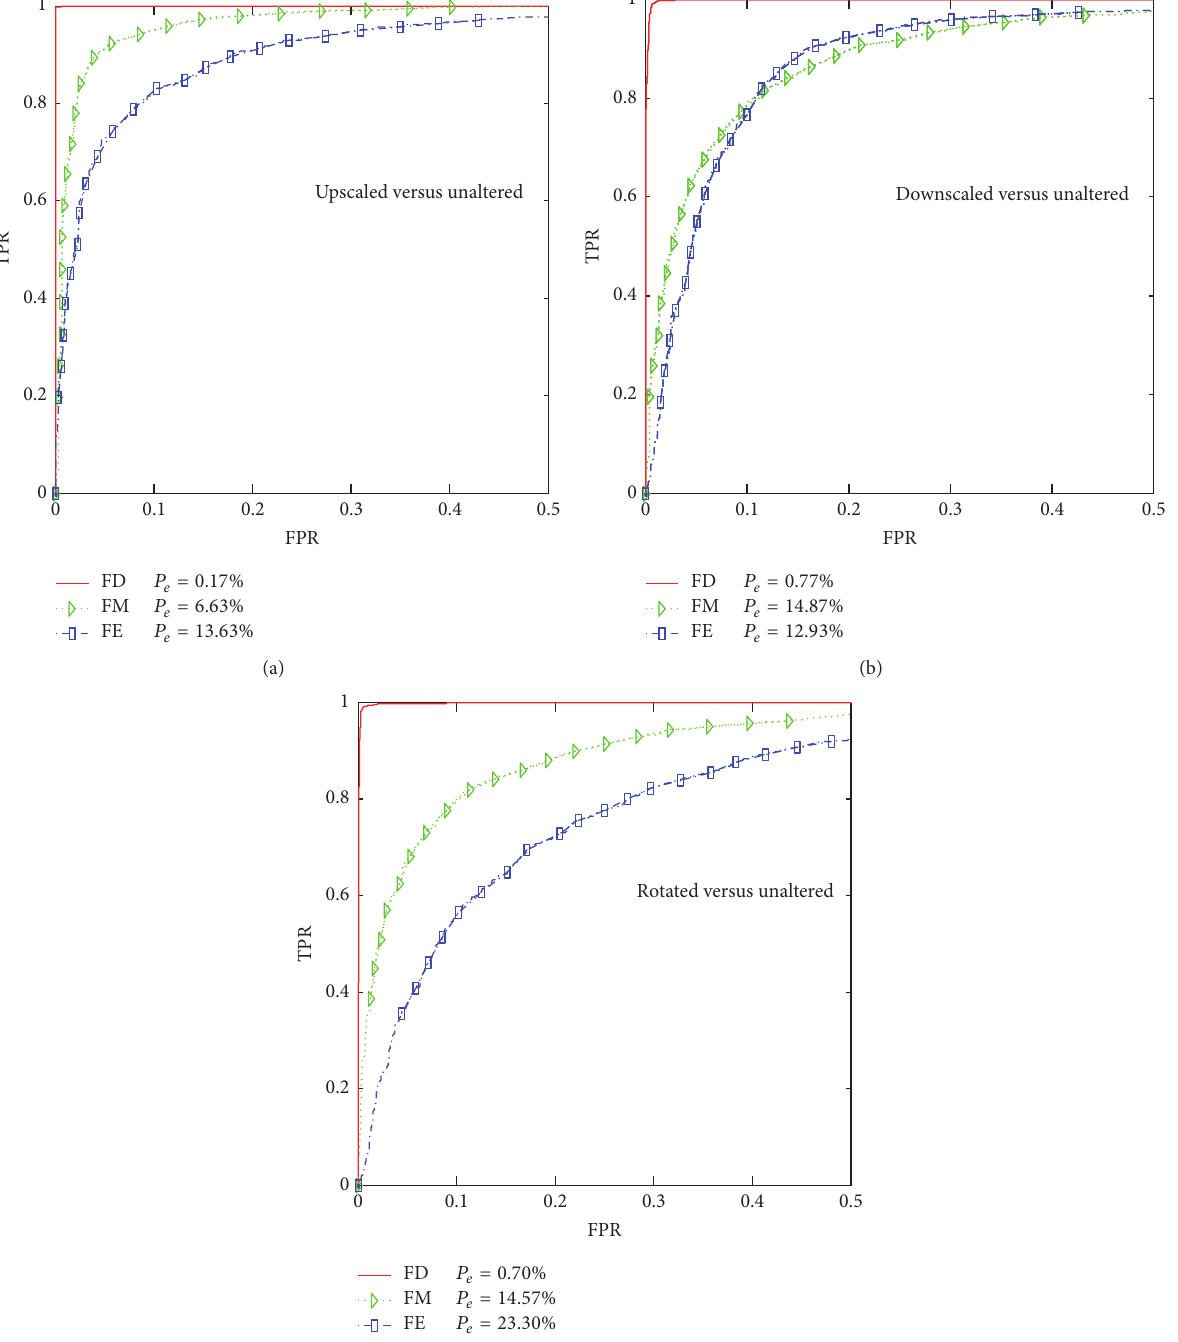
4.4. Detecting Unaltered Images from Resampled Images and Forged Resampled Images. In applications, we may have no prior knowledge about the test image. For a more practical detector, we train the SVM detector by unaltered images and “ALL” images including resampled images and forged